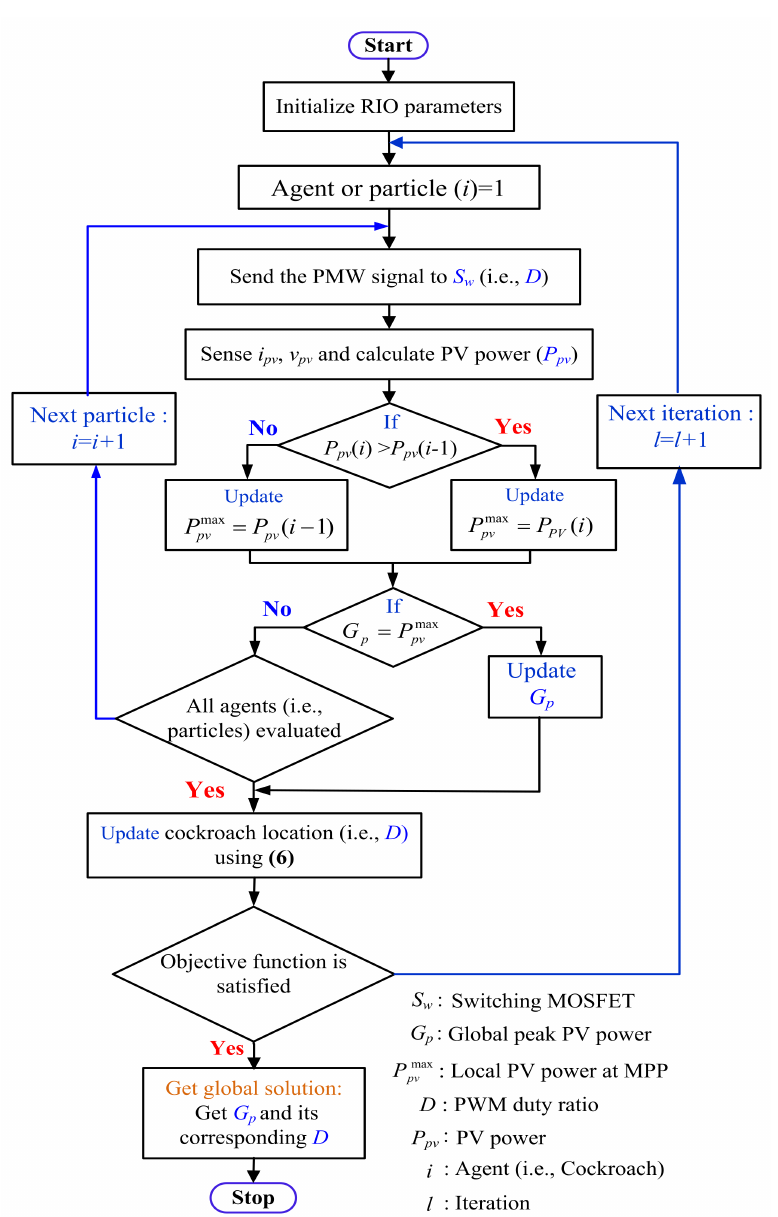
Figure 5. Flowchart of proposed RIO algorithm for